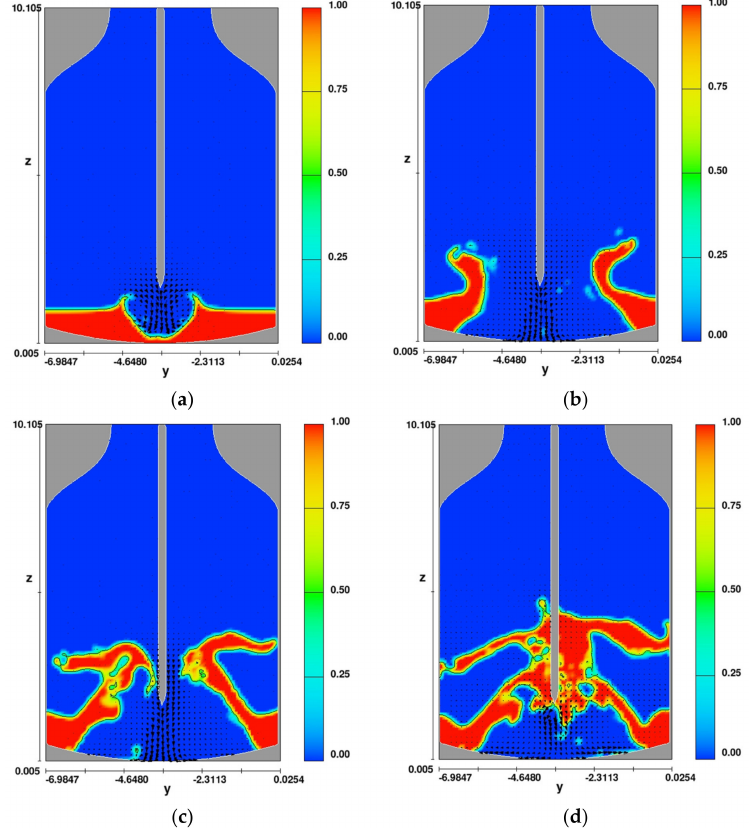
Figure 10. Distribution of phases in variant 1 for time ( a ) 0.05 s, ( b ) 0.45 s, ( c ) 0.65 s, and ( d ) 0.85